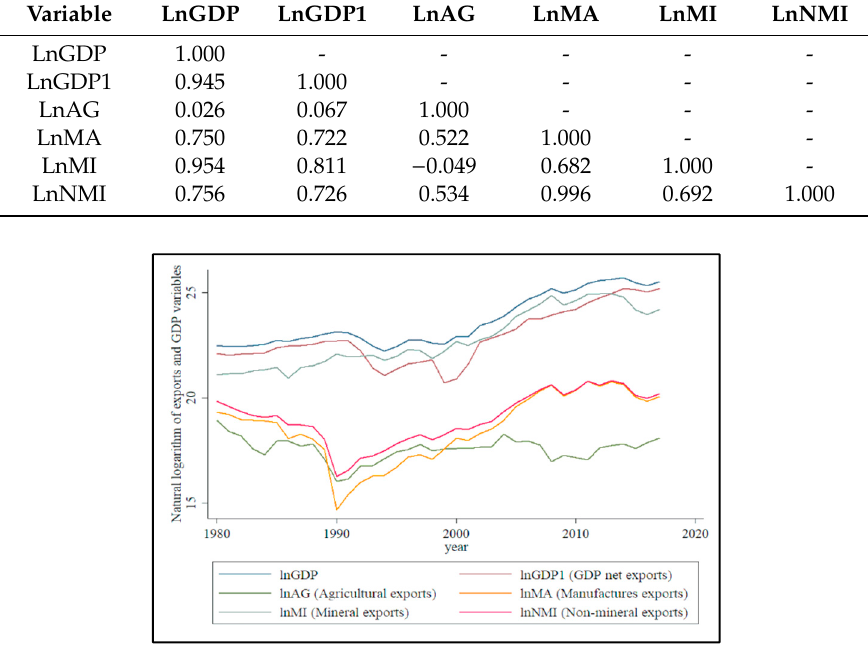
Table 4. Augmented Dickey–Fuller and Zivot and Andrews unit root test results (data 1980-2017).